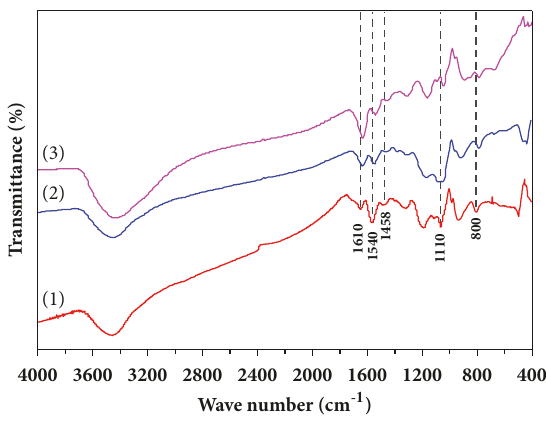
Figure 1: FTIR spectra of (1) SPO1, (2) SPO2, (3) SPO3. 80 kV. The energy dispersive X-ray spectrum (EDS) was recorded by an Oxford instrument (model 51-ADD0007, UK).